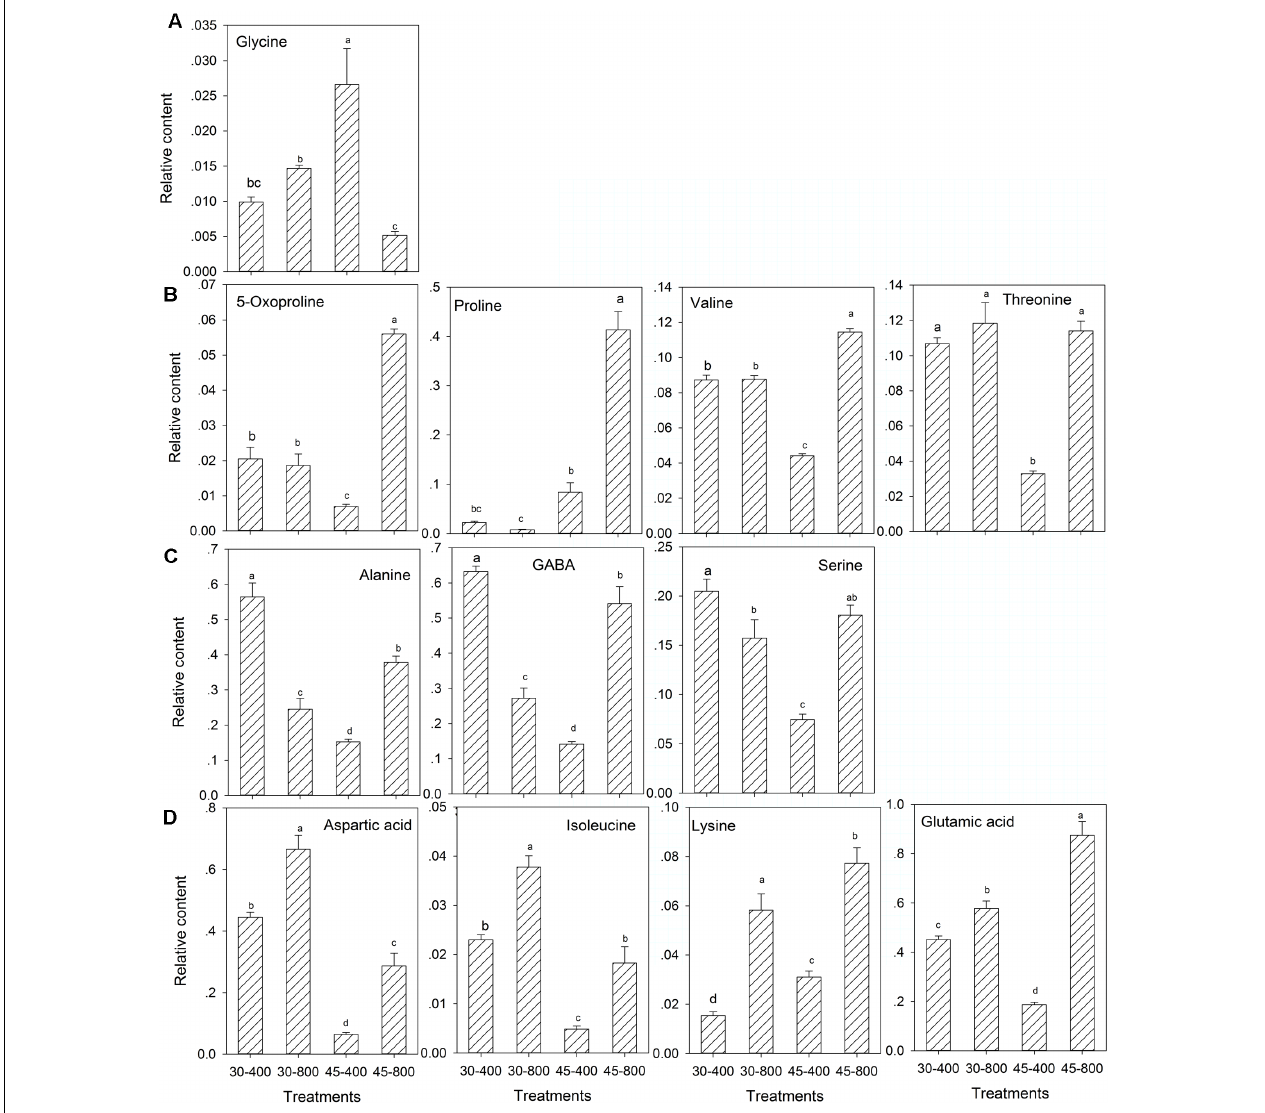
FIGURE 5 | Effects of elevated CO 2 concentration on amino acids in response to heat stress in bermudagrass. The treatments symbols are 30 and 45 for normal temperature control and heat stress and 400 and 800 for ambient CO 2 and elevated CO 2 concentrations, respectively. (A) No changes under 30–800 and down-regulation under 45–800; (B) No changes under 30–800 and up-regulation under 45–800; (C) Down-regulation under 30–800 and up-regulation under 45–800; (D) Up-regulation under both 30–800 and 45–800. Columns marked with different letters presented the significant differences based on LSD values ( P ≤ 0.05) among